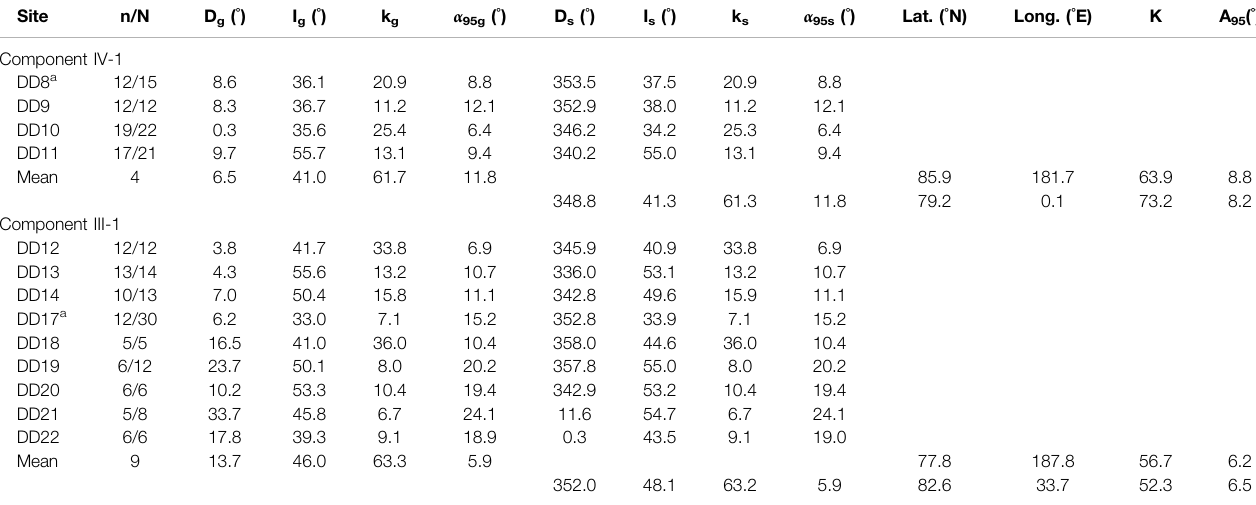
TABLE 2 | Paleomagnetic directions and statistics of low temperature components (IV-1 and III-1) from sites DD7-22 at the Dadi section.